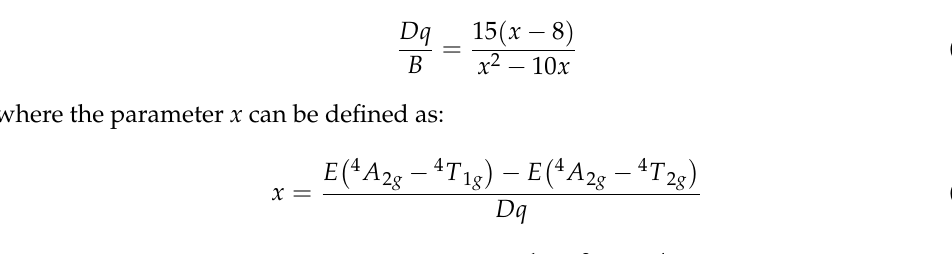
The Racah parameter B can be determined by the equation: